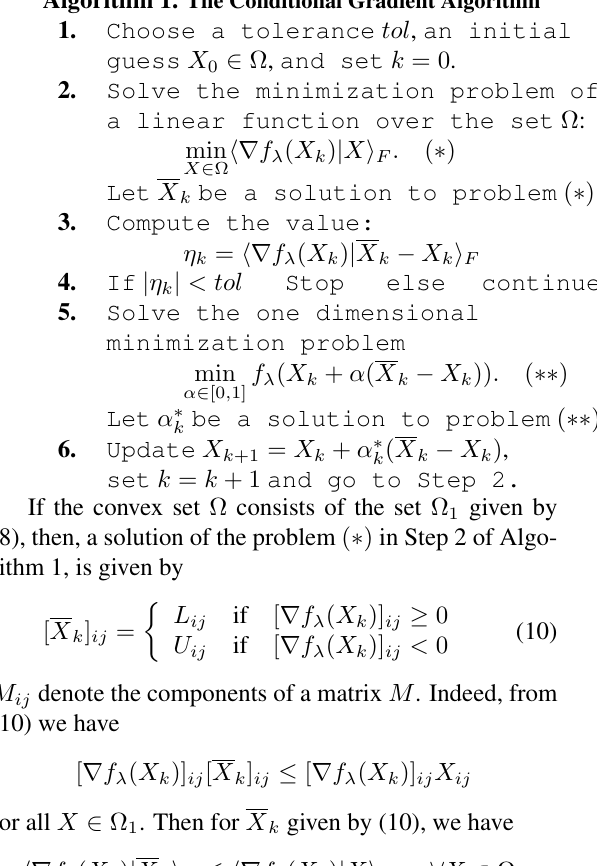
Algorithm 1. The Conditional Gradient